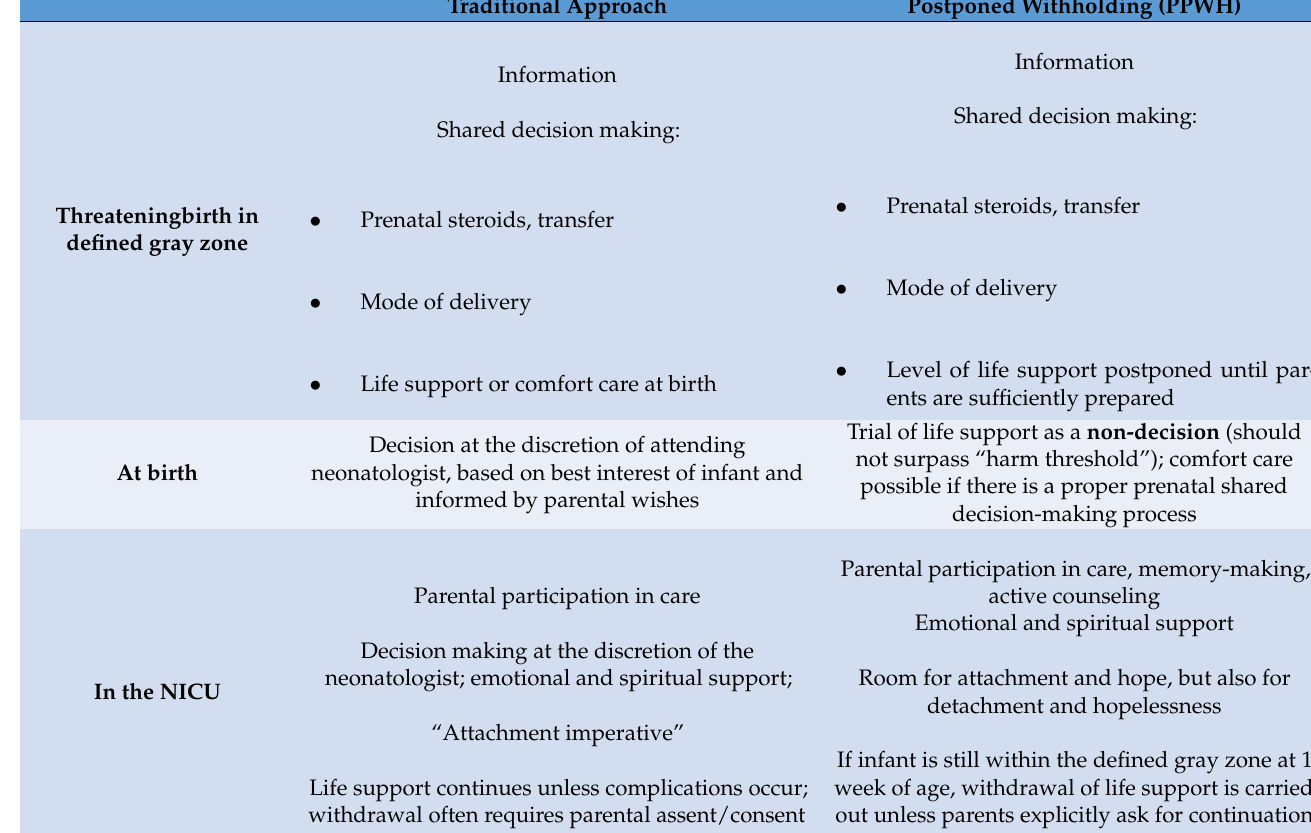
Table 2. Core elements of PPWH compared to the traditional